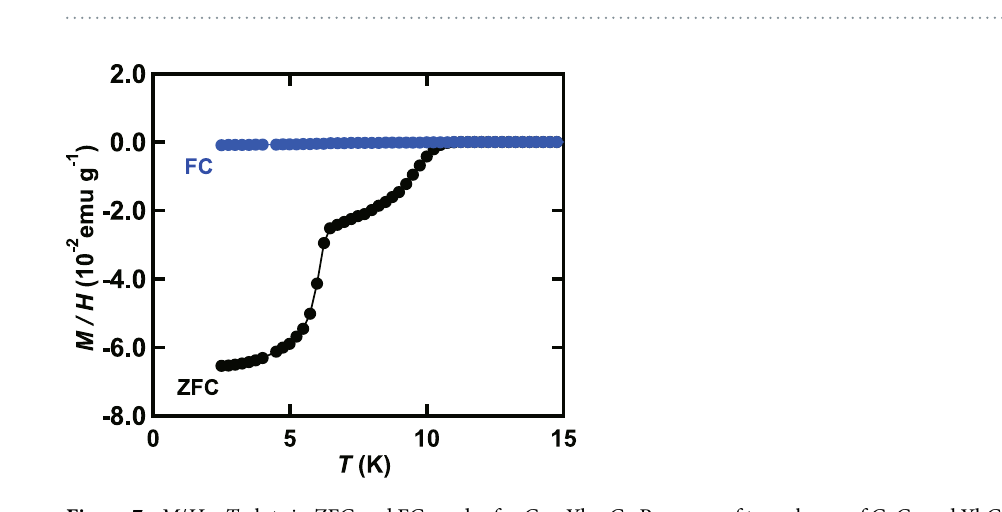
Figure 6. Pressure dependence of d AA for Ca 0.6 K 0.4 C 8 and Ca 0.5(2) Sr 0.5(2) C 6 . Dashed lines drawn in red, yellow and blue refer to the d AA values of KC 8 , SrC 6 and CaC 6 , respectively.